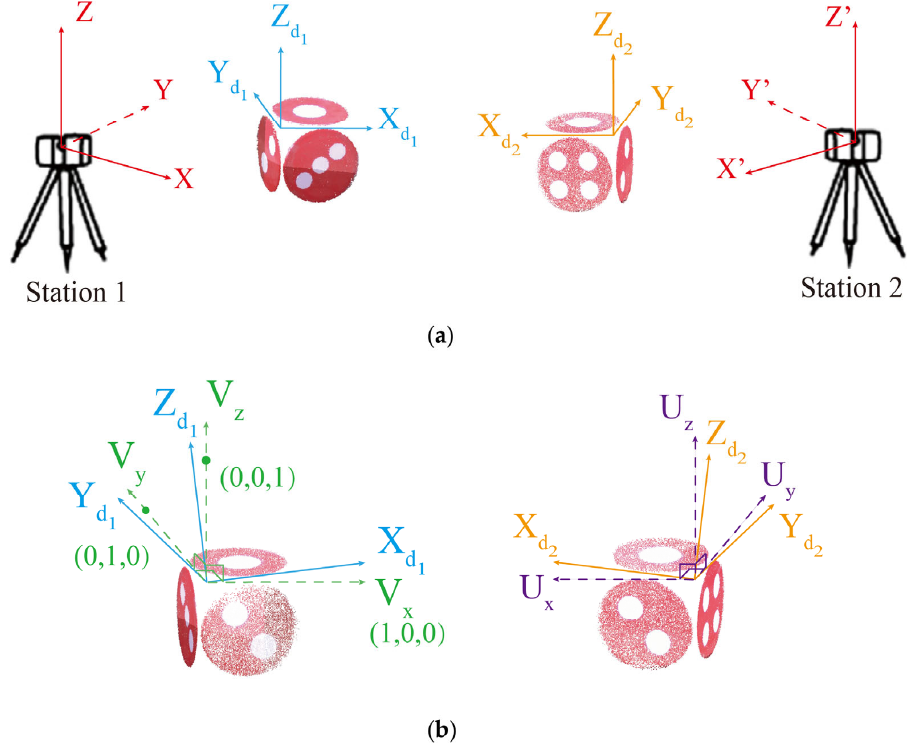
Figure 7. Coordinate system constructions for the die spaces. ( a ) Simulated axes. ( b ) After the axis orthogonality correction.